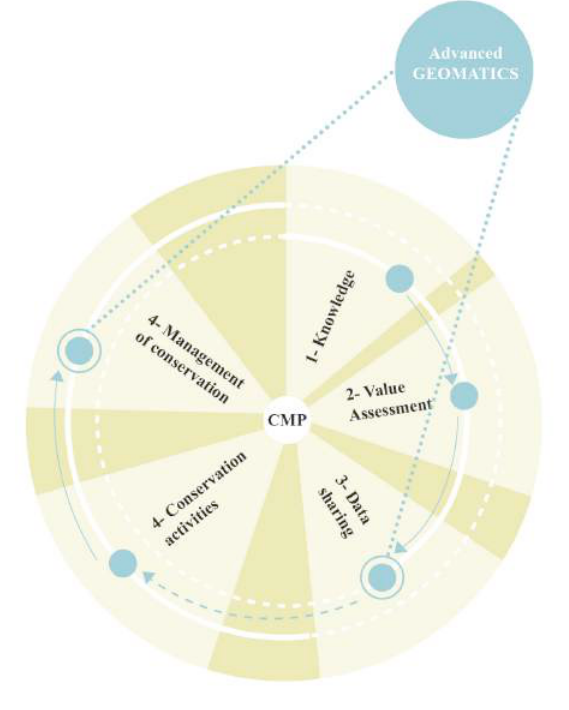
Table 3. Interaction between CMP and advanced geomatics